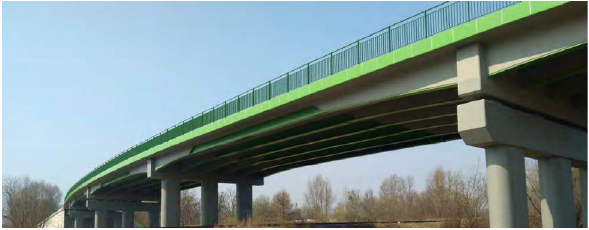
Figure 2: Bridge in Elbląg using both steel and concrete webs in the girder [4,